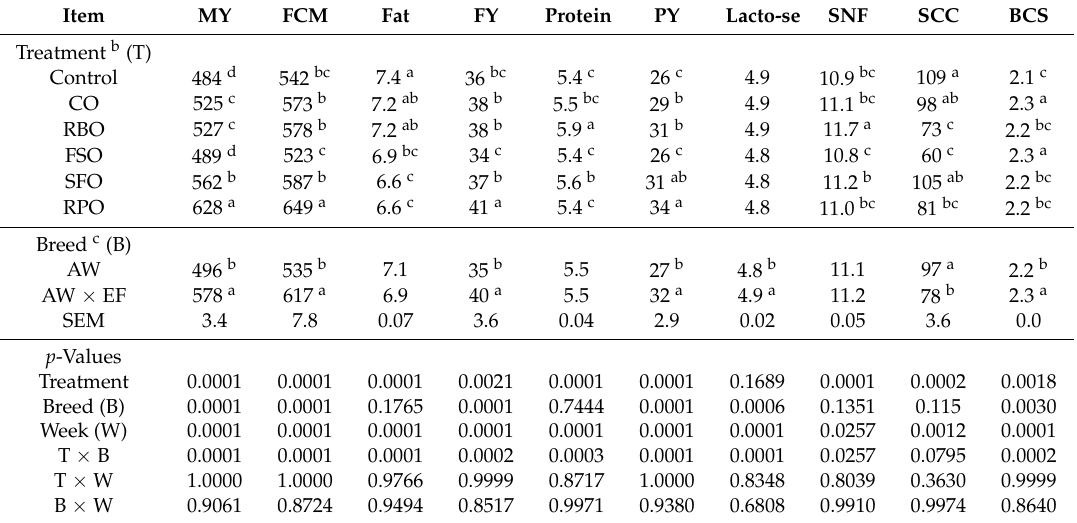
Table 4. Effect of supplementation with diverse plant-derived oils on body condition score and lactation performance traits a